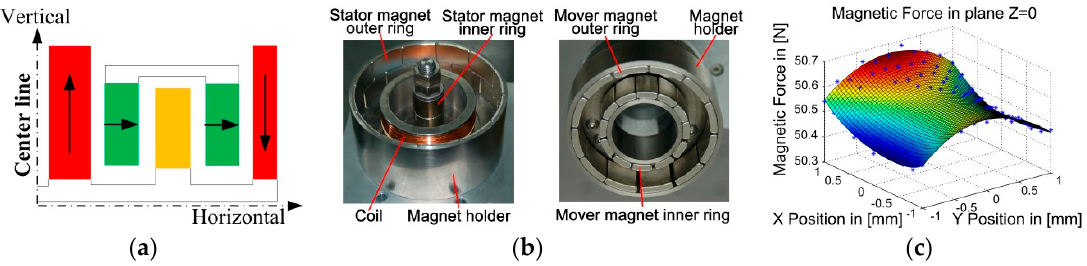
Figure 4. ( a ) Principle schematic, ( b ) pictures, and ( c ) tested magnetic levitation force of Magnetic Gravity Compensators (MGC) in the plane Z = 0.